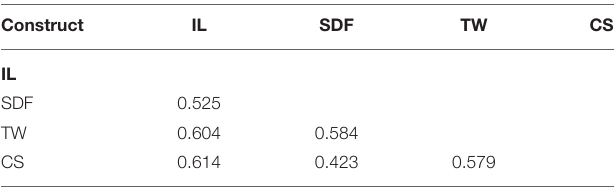
TABLE 3 | Discriminant validity analysis (HTMT).